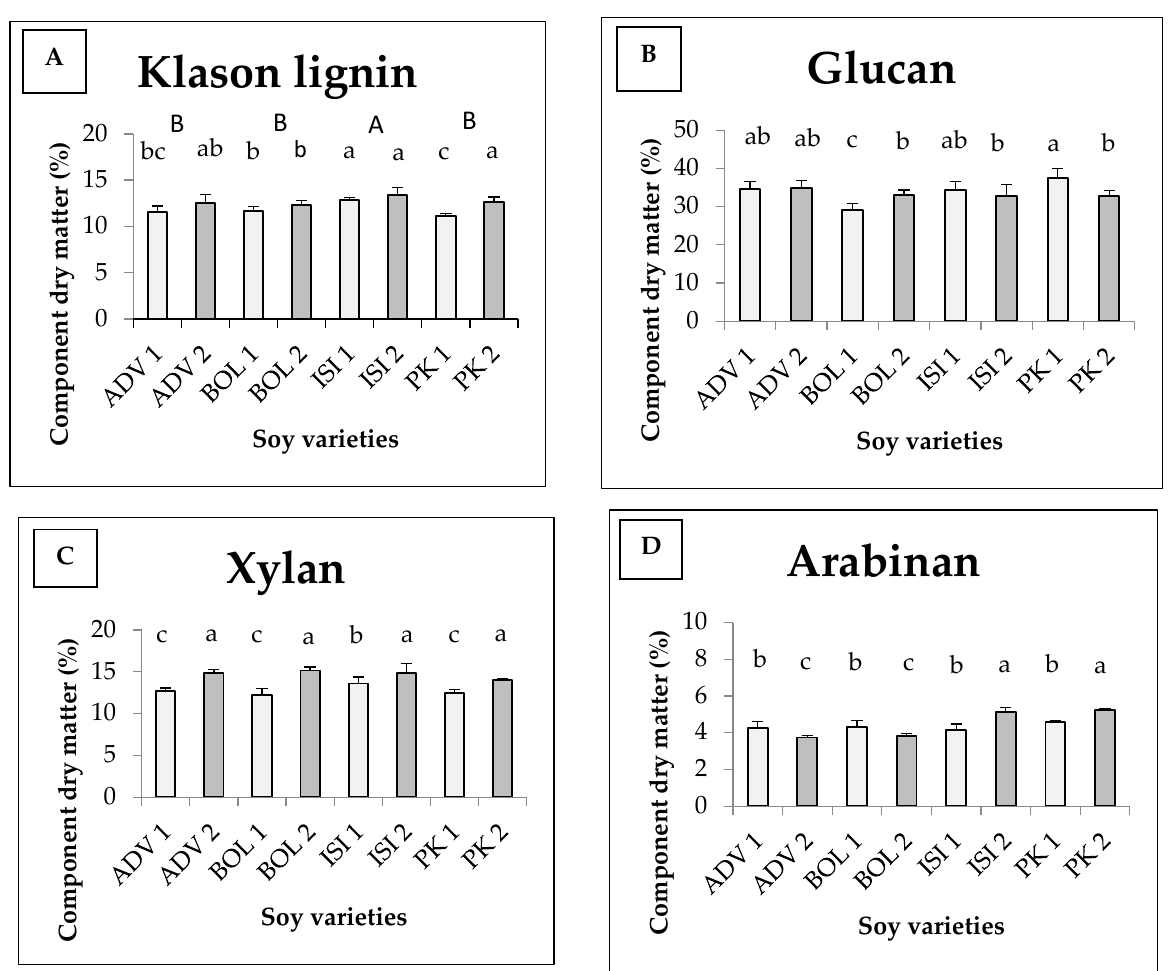
Figure 3. Average Klason lignin ( A ) content and glucan ( B ), xylan ( C ) and arabinan ( D ) components of different soy varieties as a function of harvest time (+SD). Different letters above the columns refer to significant differences ( p ≤ 0.05). In Figure 3A, the capital letters (A,B) indicate varieties; the normal letters (abc) indicate the harvest.